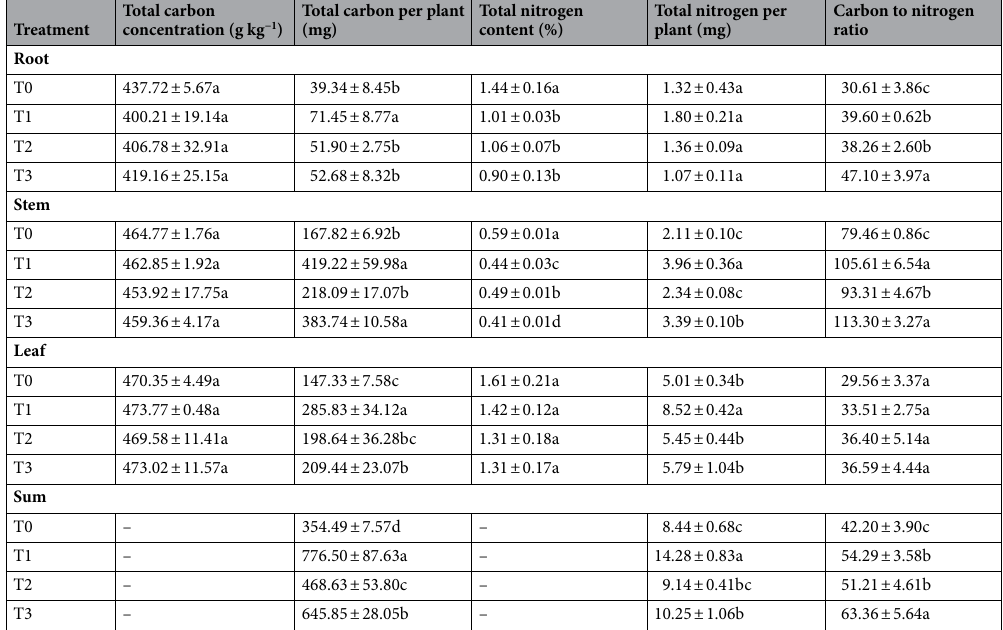
Table 7. Effects of the mixture of rice husk ash and red soil with various proportions on the carbon and nitrogen status in different parts of cotton seedlings.